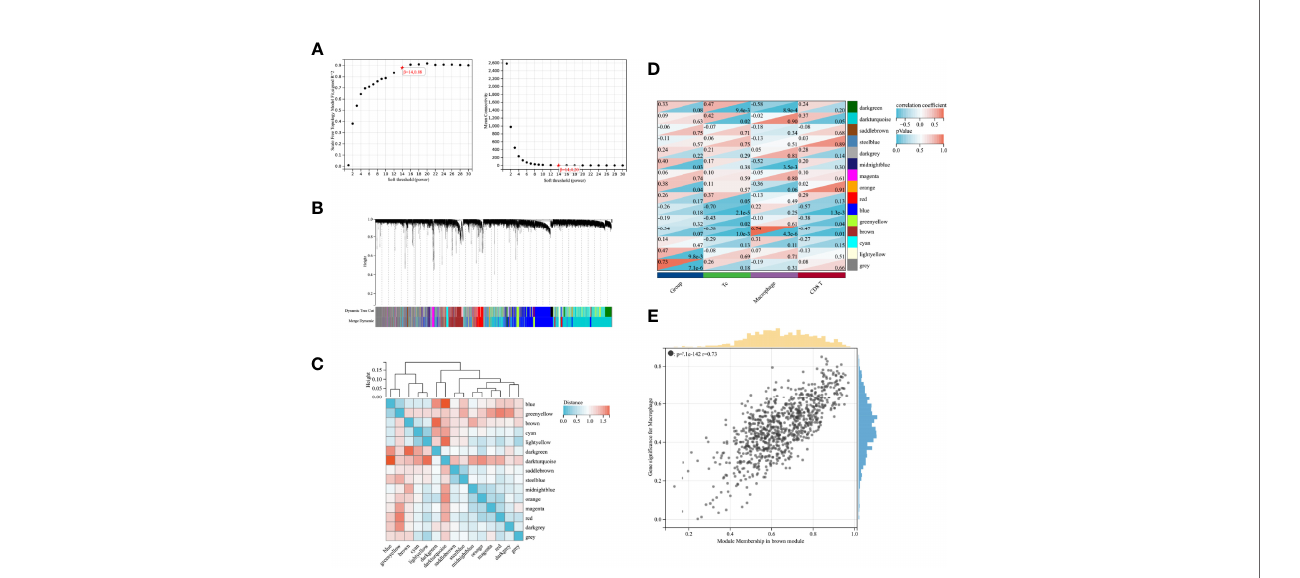
FIGURE 2 | WGCNA screening of gene modules associated with immune in fi ltration (A) Scale-free fi t indices and mean connectivity for soft thresholds; (B) Dendrogram of immune-associated genes based on phase dissimilarity metric clustering; (C) Module feature vector clustering; (D) Heat map of gene modules with feature correlation; (E) Module feature genes associated with Macrophage abundance in brown